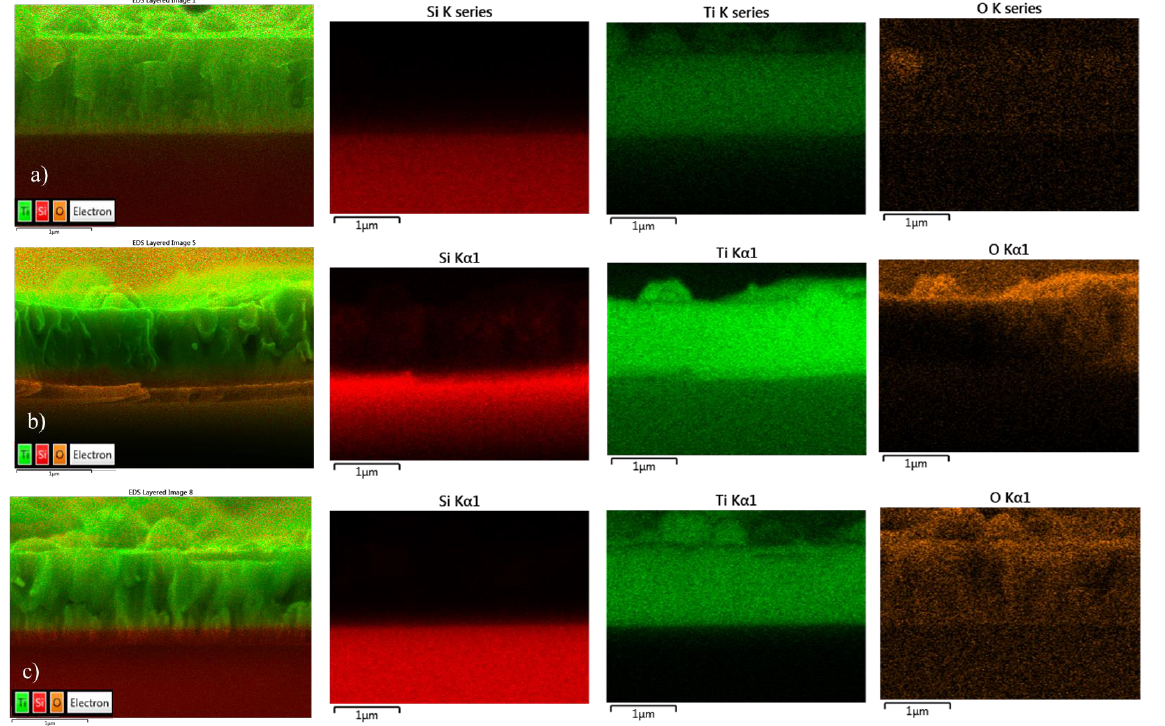
Figure 4. EDS mapping of the arc-PVD TiO x coatings deposited with ( a ) 440 Ar/60 O 2 , ( b ) 400 Ar/100 O 2 , and ( c ) 300 Ar/100 O 2.